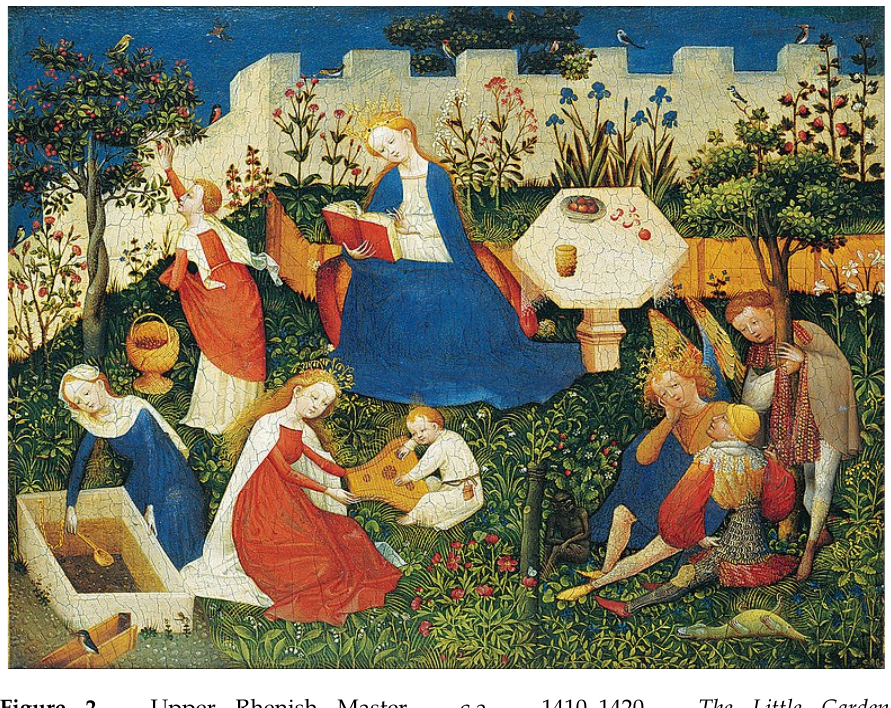
Figure 2. Upper Rhenish Master. c.a.1410–1420. The Little Garden of Paradise. https://upload.wiki-